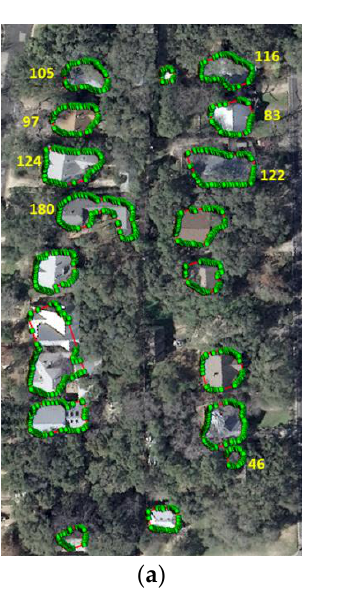
Figure 19. Smoothing results for the buildings in urban areas with relatively larger in size (count of vertices is showing inside the polygon): ( a ) initial polygons; ( b ) smoothed polygons.